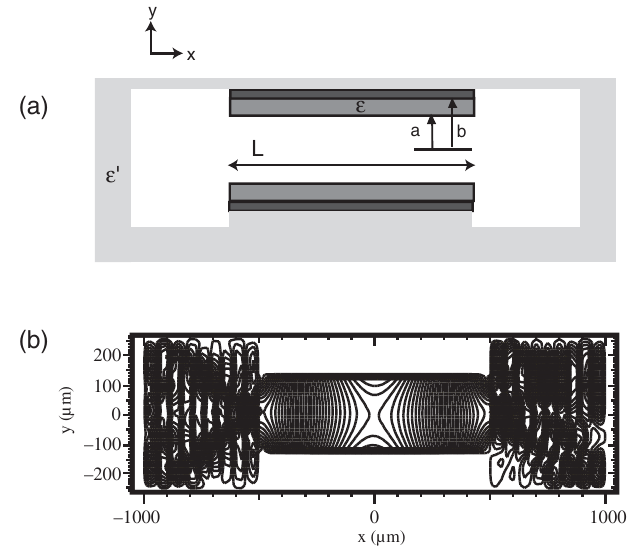
FIG. 7. (a) Geometry of a possible manufacturing approach to the slab-symmetric structure. (b) Accelerating field (from GDFIDL eigenvalue simulation) in such a structure, without coupling slots. The cosinusoidal field dependence in x leads to a slight hyperbolic dependence in y